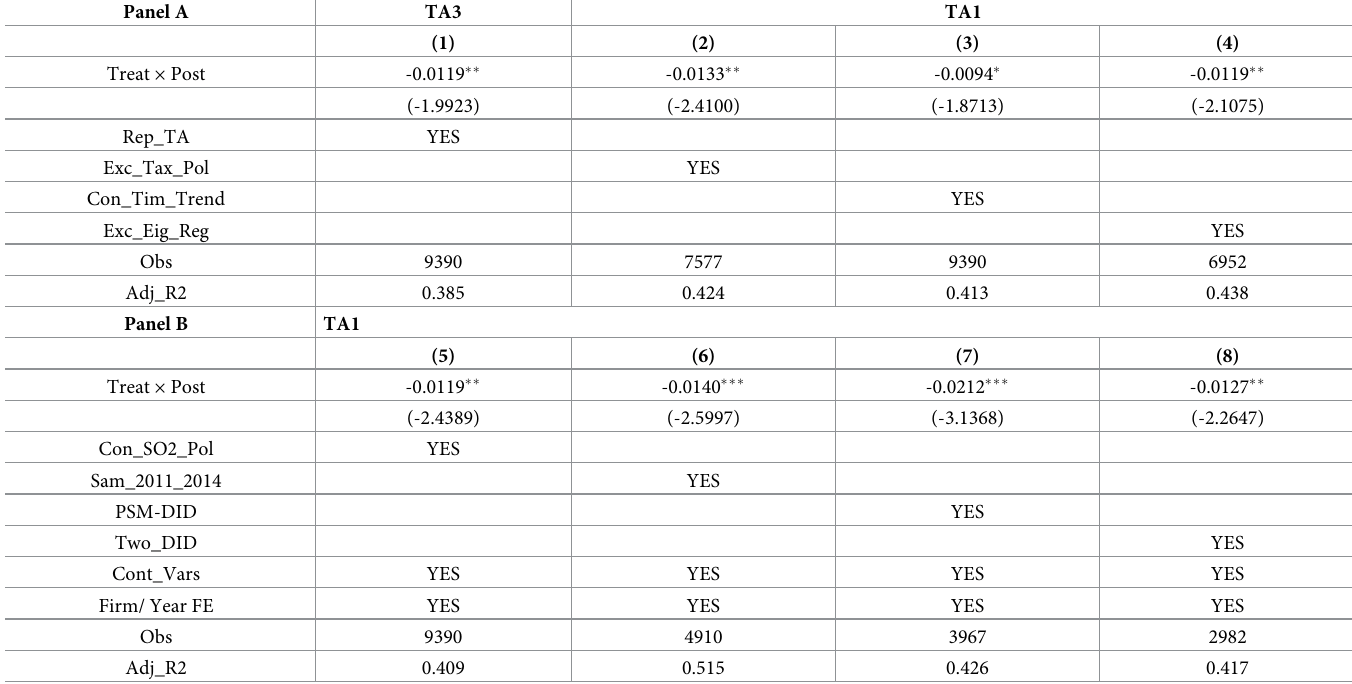
Table 4. Robustness and endogenous